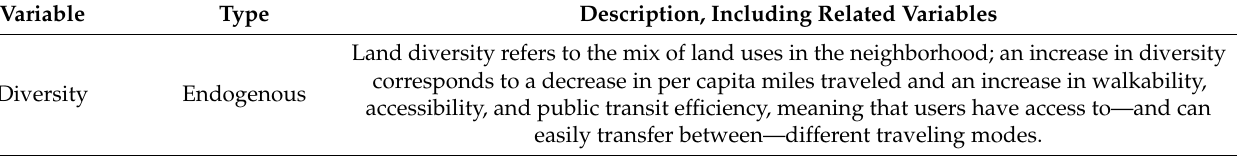
Table 2. Variable selection and